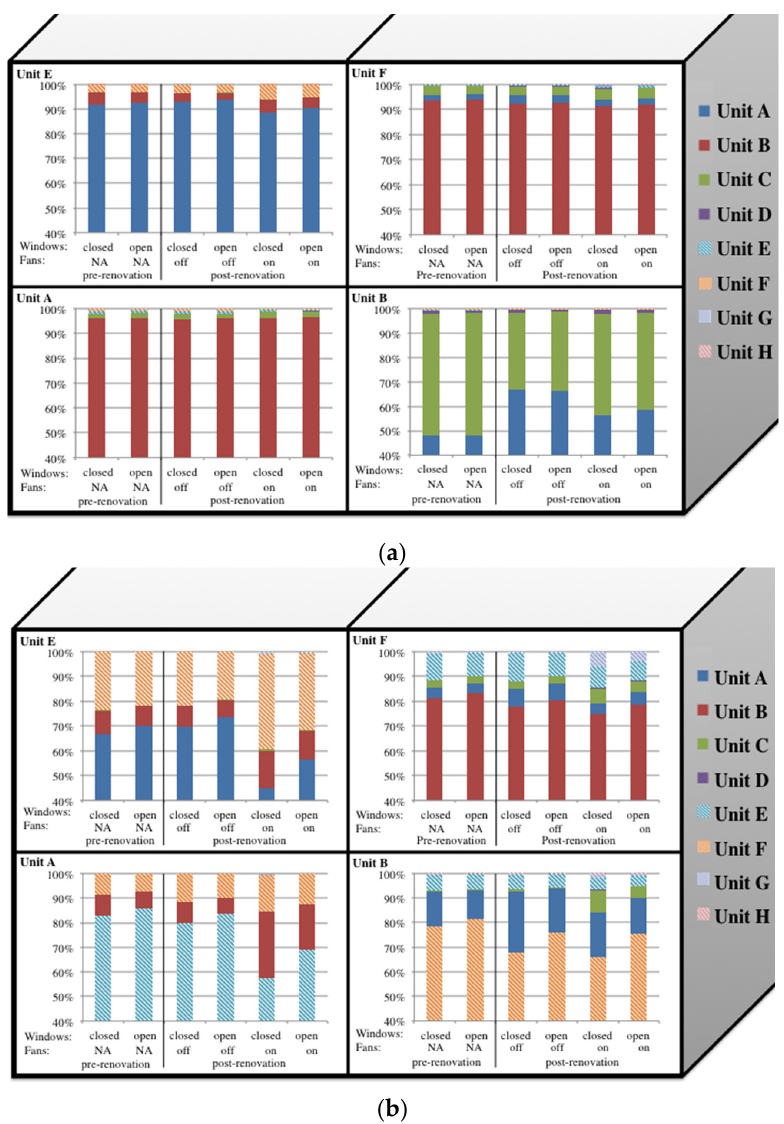
Figure 3. Percent ETS PM 2.5 infiltrating from all other units into each apartment unit in the ( a ) winter, and ( b ) summer, across all simulated factors (windows open/closed, exhaust fans on/off, retrofit pre/post). In-unit ETS PM 2.5 is not represented in this figure. Building is 2 units high and 4 units across, and only half the building is shown in the figure. A and E are end units, and B and F are interior units adjacent to units A and E (shown) and C and G (not shown). NA = not applicable as exhaust fans were not installed pre retrofit. Kitchen and bathroom exhaust fans were only operated in units A and E, so the influence of fans in units B and F reflect only fan activity in adjacent units.